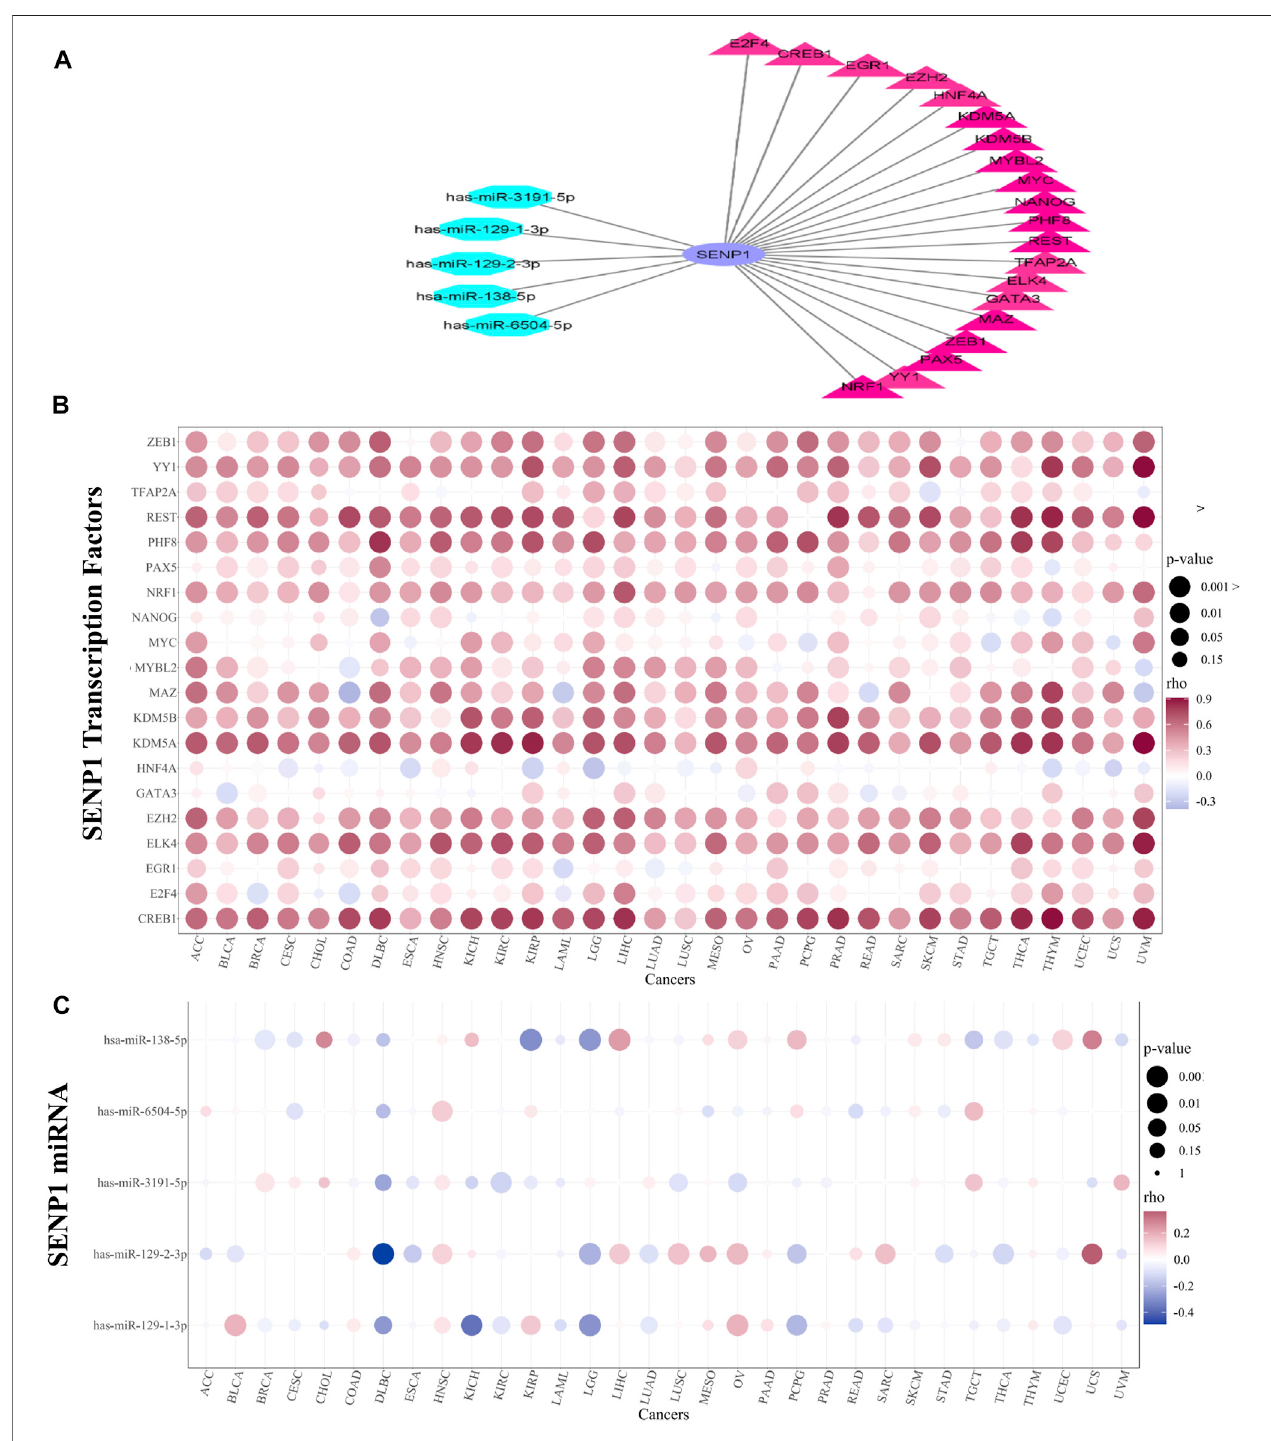
FIGURE 3 | TF and miRNA regulatory networks. (A) TF and miRNA network, (B) Bubble plot of TFs alterations in 32 cancers, and (C) Bubble plot of miRNAs alterations in 32 cancers.